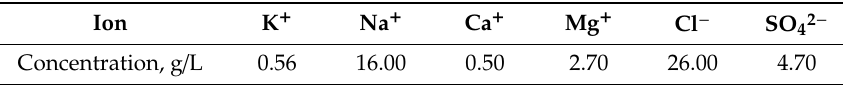
Table 2. Ionic compositions of the seawater taken from the South China Sea.